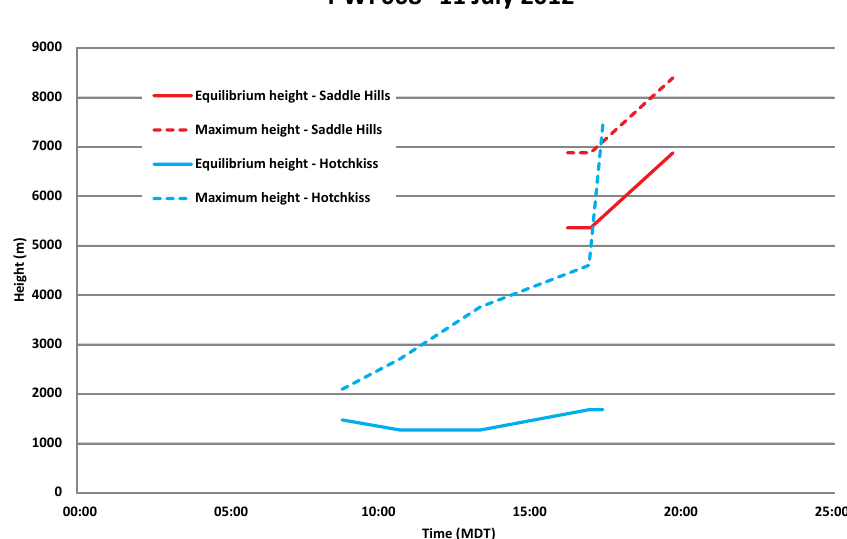
Figure 4. Evolution of observed plume heights for PWF068 from Hotchkiss at 24km (blue) and from Saddle Hills at 173km (red). Table 4. A summary of weather and fire weather characteristics. Variable